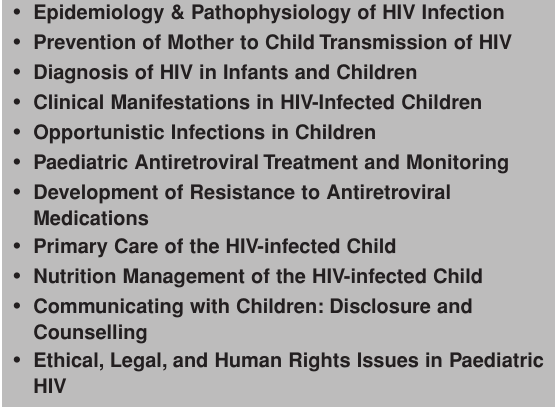
Fig. 1. Paediatric HIV training